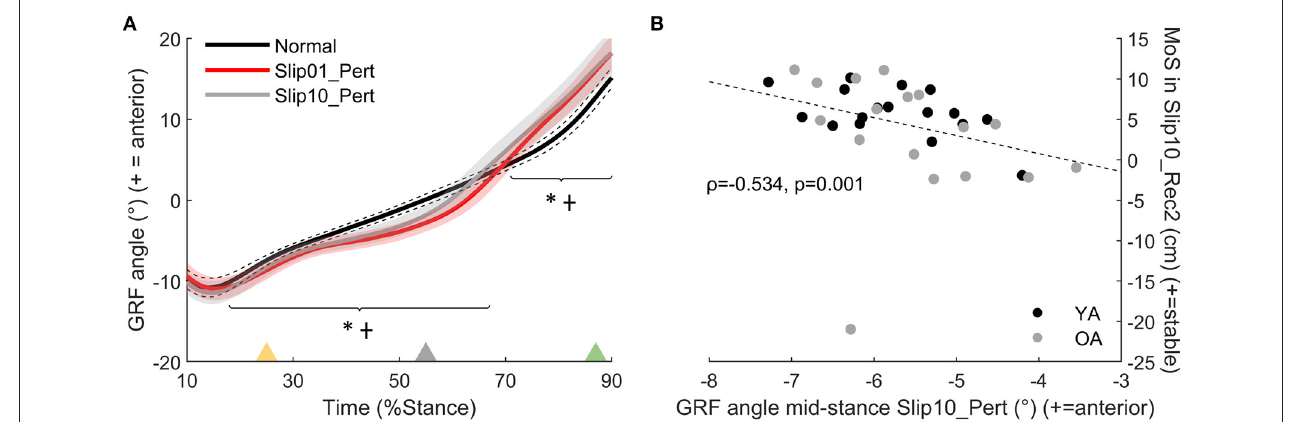
FIGURE 4 | (A) Ground reaction force angle (GRF θ ) ( ◦ ), effect of condition between Normal (black line), Slip01_Pert (red line), and Slip10_Pert (grey line); *: Slip01 significantly different from Normal p < 0.001 from 18 to 67% and from 71 to 90% of stance; †: Slip10 significantly different from Normal p < 0.001 from 15 to 60% and from 68 to 90% of stance. Yellow triangle: beginning of belt acceleration; grey triangle: peak belt speed; green triangle: belt speed returns to 1.2 m · s − 1 . See Supplementary Figure 4 for YA and OA curves. (B) Correlation between GRF θ during mid stance of Slip10_Pert and MoS in Slip10_Rec2 (Spearman’s rho = − 0.534, p = 0.001). Black circles: young adults; grey circles: older adults.